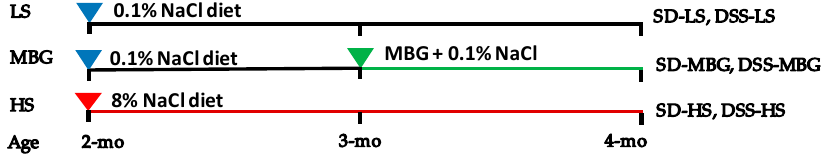
Table 1. Basic parameters in Sprague–Dawley rats and Dahl salt-sensitive rats following a low-salt